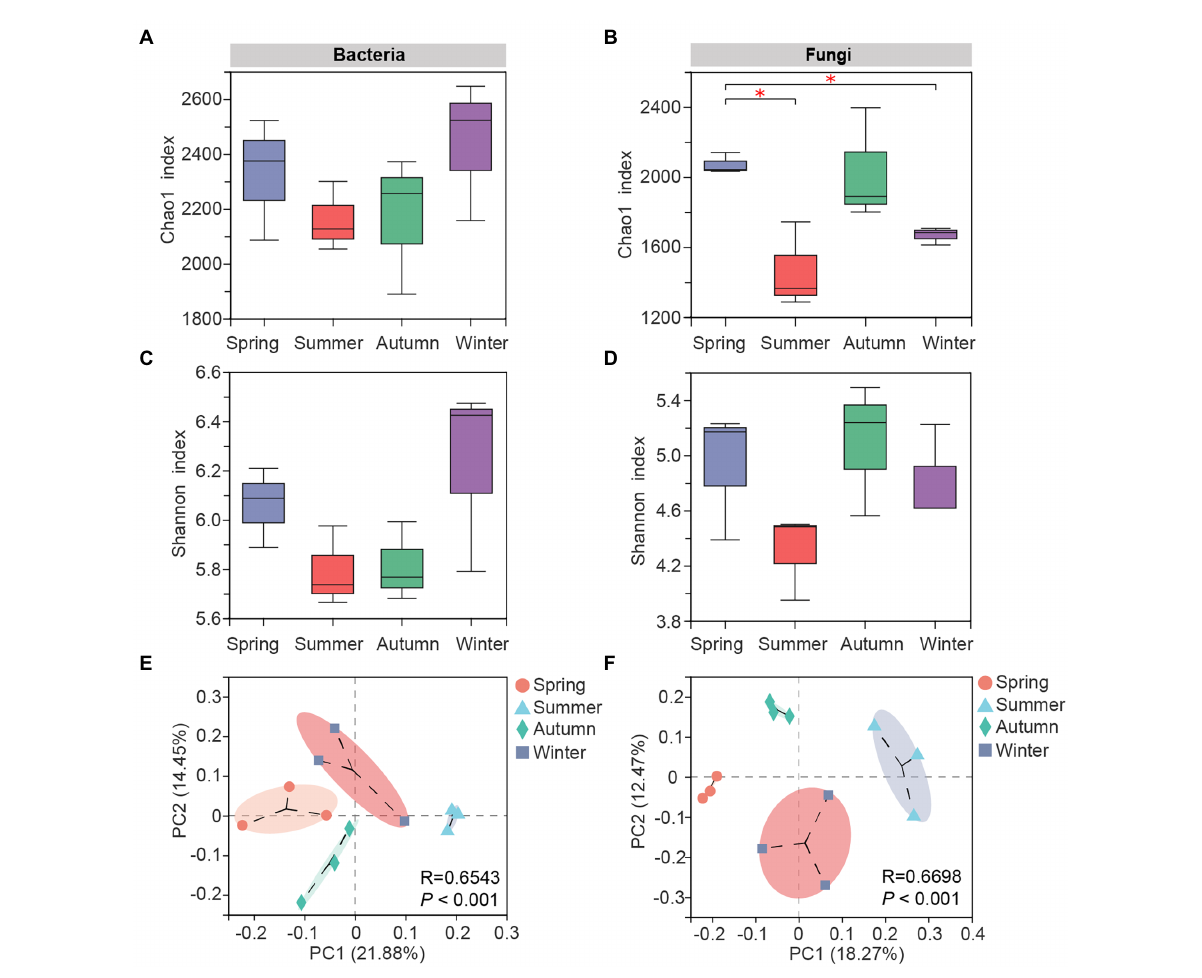
FIGURE 2 Alpha and beta diversity of rhizosphere microbes in C . pingbianense in different seasons. (A,B) Chao1 indexes of bacterial (A) and fungal (B) communities. (C,D) Shannon indexes of bacterial (C) and fungal (D) communities. (E,F) Principal coordinate analysis (PCoA) of bacterial (E) and fungal (F) communities based on the Bray-Curtis distance algorithm. *Significant differences at p <0.05